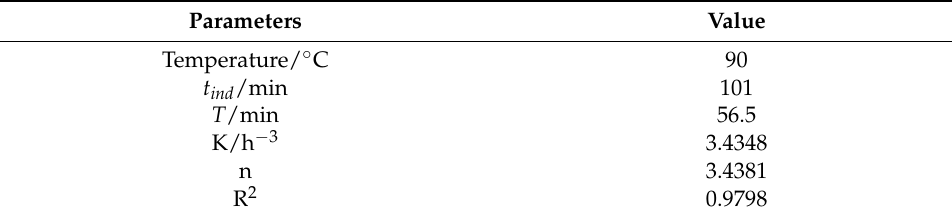
Table 6. Fitting parameters of JMA model at 90 ◦ C.